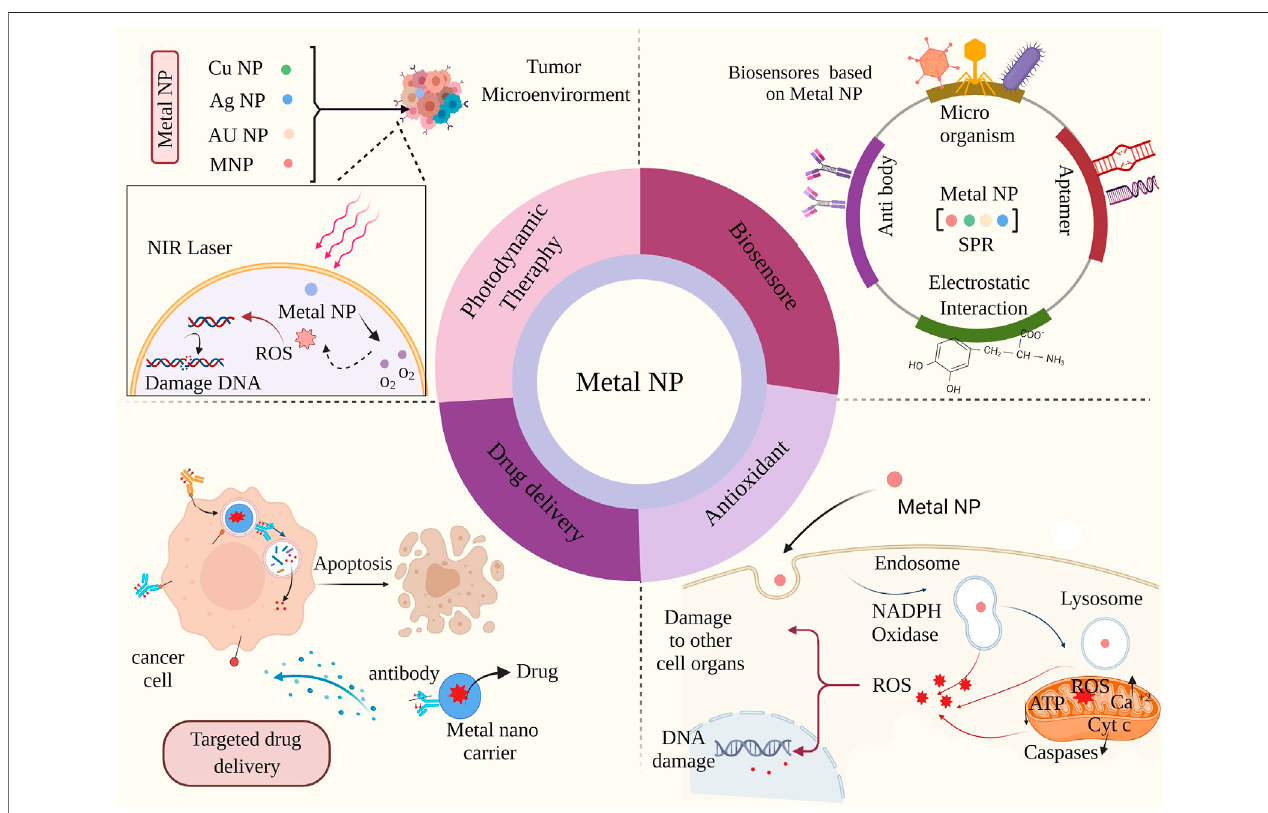
FIGURE 3 | Miscellaneous biomedical applications of metal nanoparticles: Metal nanoparticles cause further damage to cancer cells and cell death through photodynamic treatment with TME irradiation. Metal nanoparticles can also be used as biosensors.